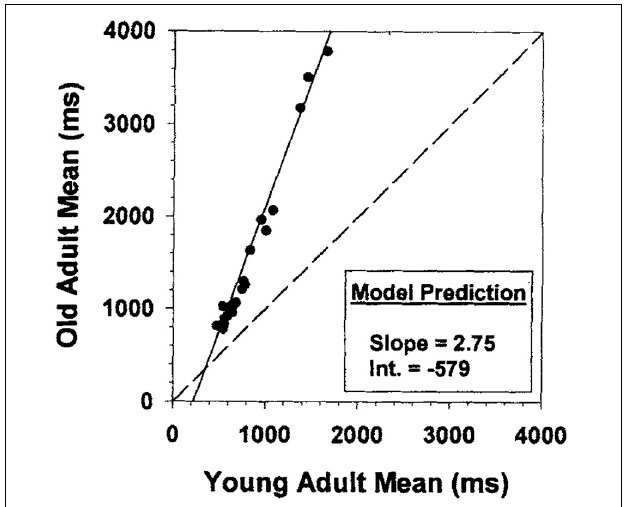
FIGURE 1 | Brinley plot from Faust et al. (1999). Brinley plot from Faust et al. (1999) with data from 26 different studies drawn from Hale et al. (1995).